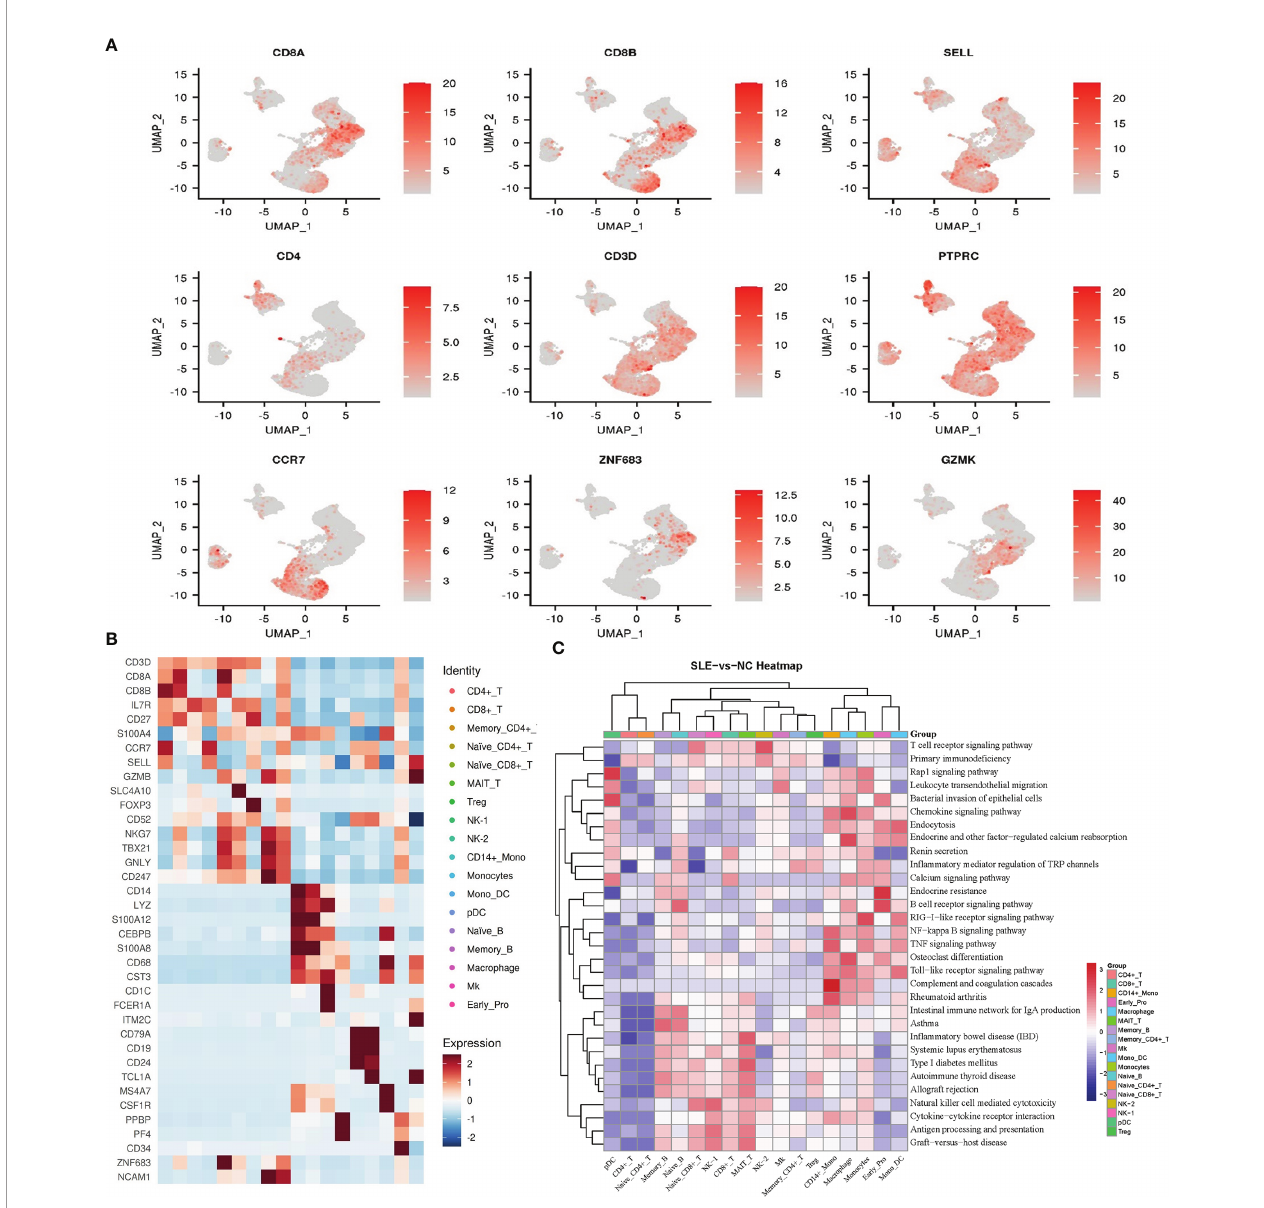
FIGURE 2 | Cell type identi fi cation and functional analysis of differential genes between the AS-PBMC and NC-PBMC. (A) UMAP plots of canonical cell markers used to identify clusters, color-coded for expression levels. (B) Heatmap to show the expression levels of the selected gene markers of each cell type. (C) Pathway enrichment analysis (KEGG) of signi fi cantly differential gens between the AS-PBMC and NC-PBMC libraries (p < 0.05). Heatmap expression is the result of Z-score column-wise normalization. The P-value is represented by the color. All P values are less than 0.05. The redder the color, the smaller the P value, indicating that the enrichment was more notable. The white color represents that DEGs of this cell type is not enriched in this signaling